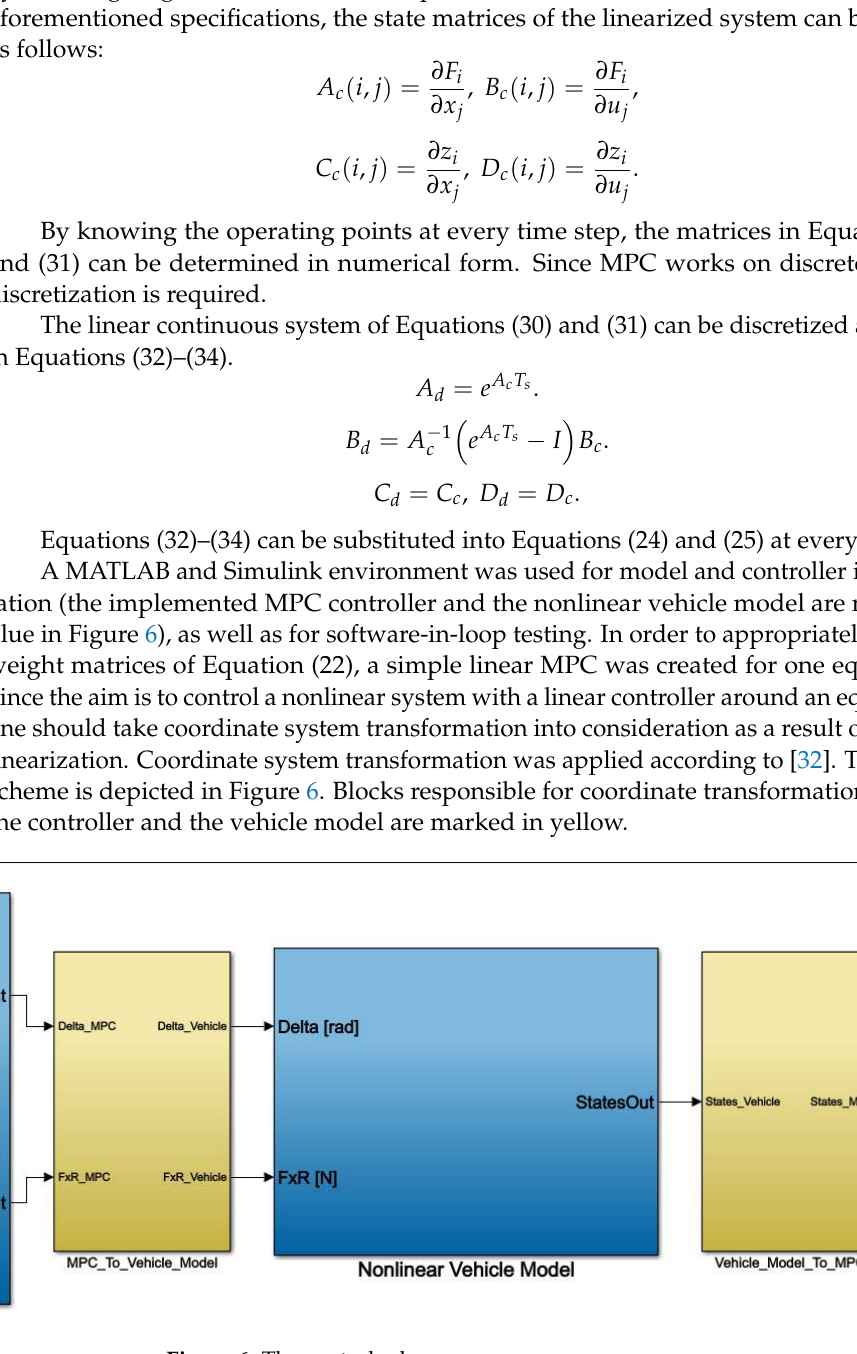
Figure 6. The control scheme.